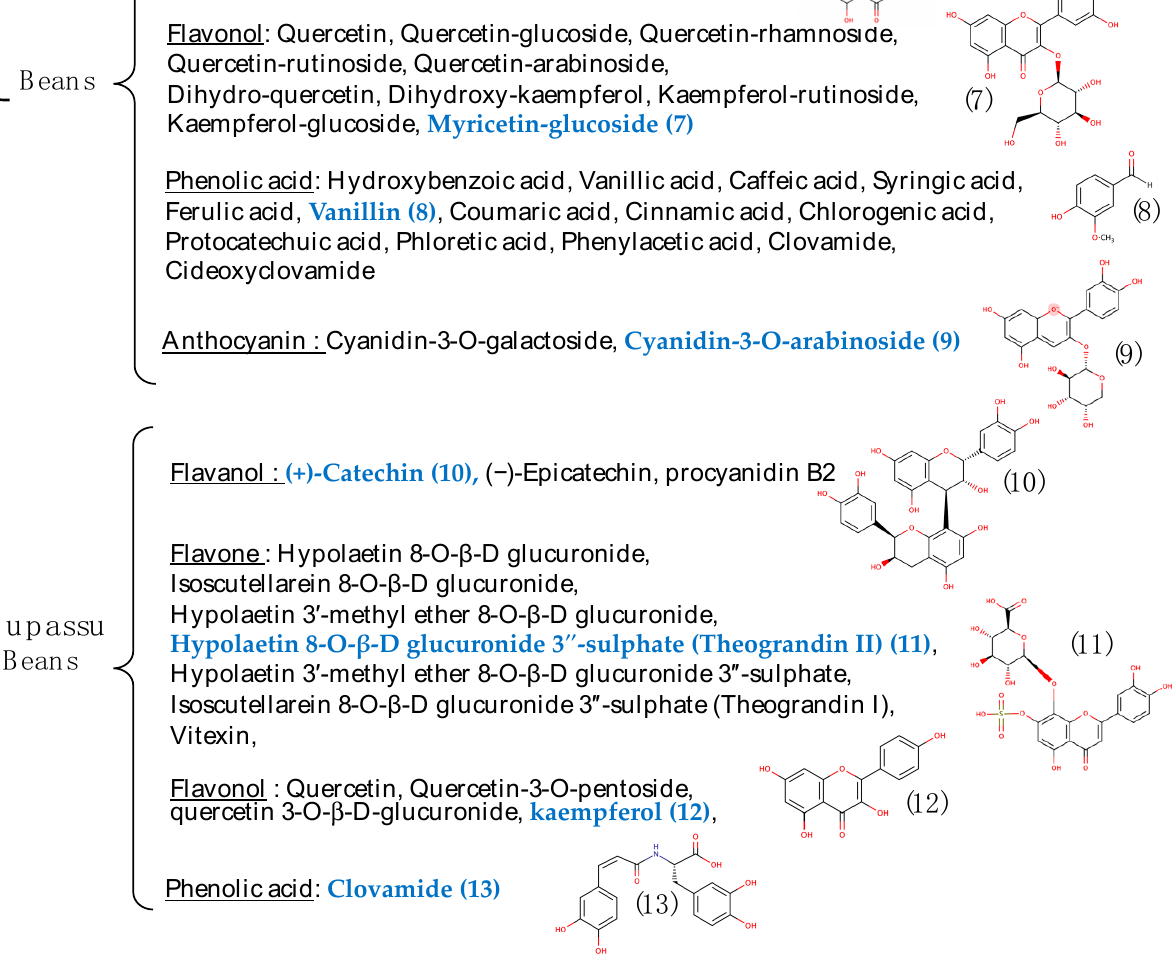
Figure 3. Polyphenols identified in pods and beans of cocoa and cupuassu, with examples of their chemical structures (in blue). Data from